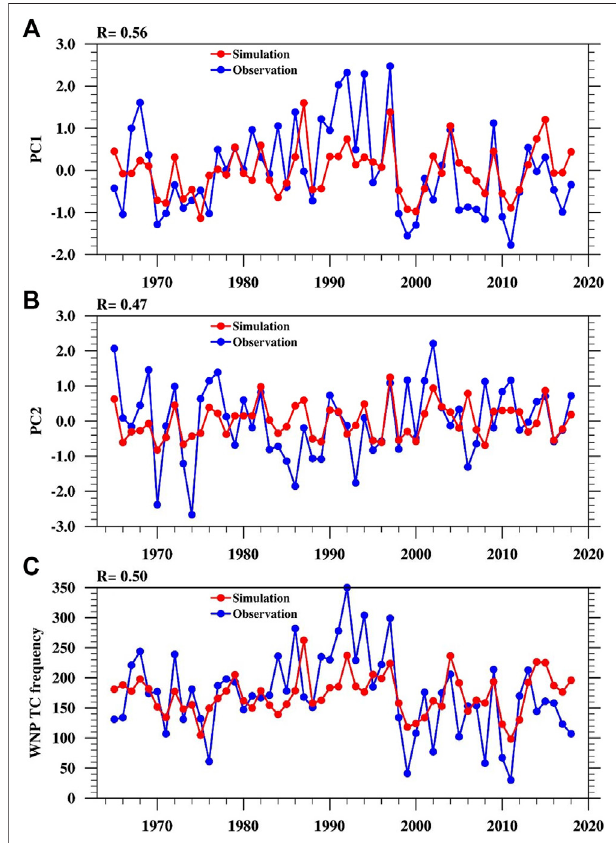
FIGURE 7 | Time series of observed (blue line) and simulated (red line) (A) PC1, (B) PC2, and (C) TC track frequency over the WNP during 1965 – 2018. Correlation coef fi cients are shown on the top left of